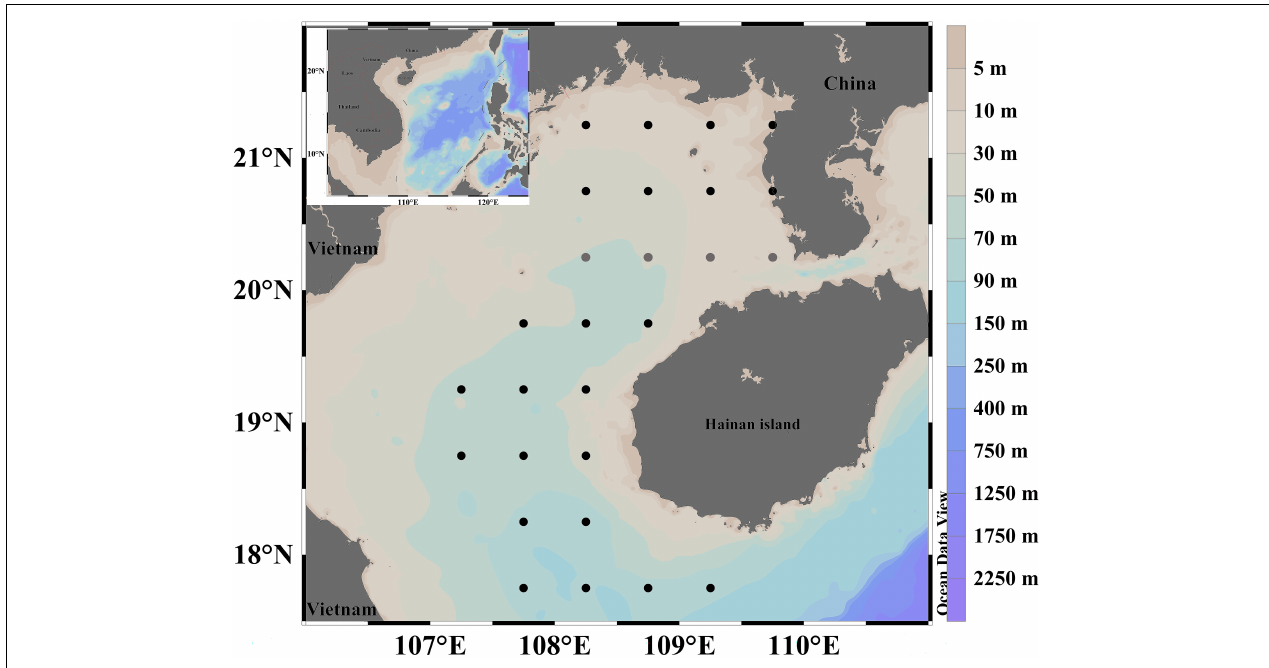
FIGURE 1 | Sampling stations of fish eggs in the eastern Beibu Gulf. The black dots indicate the stations where the spring and late autumn-winter survey was conducted, the gray dots indicate the stations where only the spring survey was